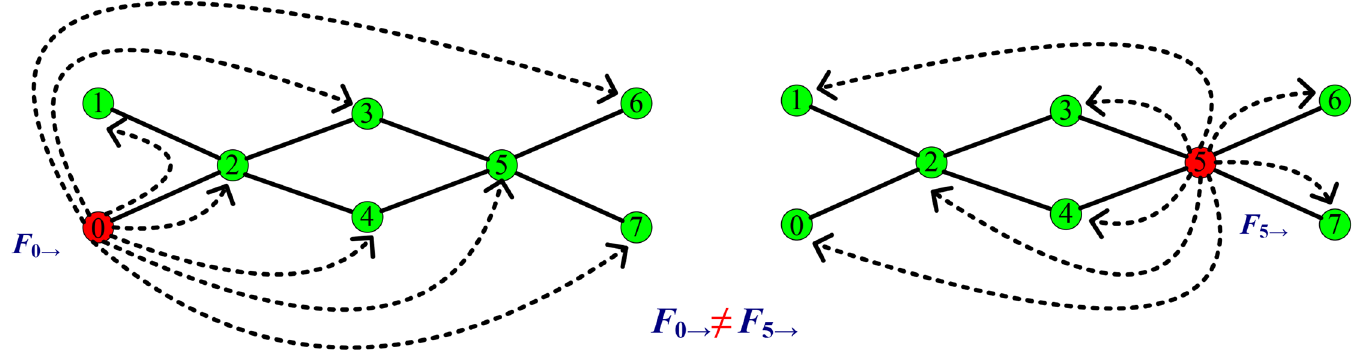
Fig 2. Node degree influences the number of the load generated by this node. In the Internet, traffic networks, and the power grid, in general, the bigger the degree of a node, the higher the load generated by it. We define F i ! to represent the total load generated by node i , which is transported to other nodes in a network. Owing to the effect of the node degree, F 0 ! should be not equal to F 5 !